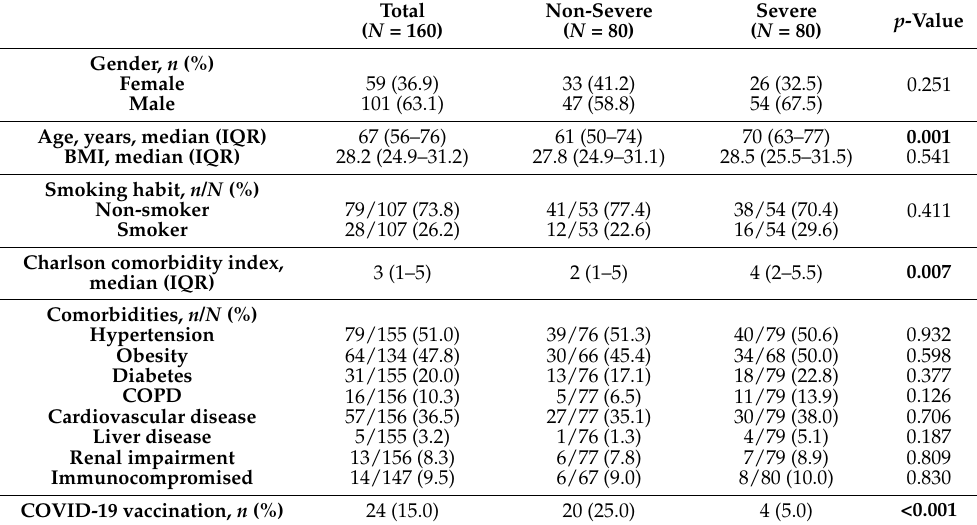
Table 1. Summary of baseline characteristics of enrolled patients. Baseline demographic, clinical features (comorbidities), and vaccination status of the enrolled patients ( n = 160). Patients were stratified according to the severity of the disease into a “non-severe” group and a “severe” one. Data are presented as either percentage or median and interquartile range (IQR). Results of the comparison between “non-severe” vs. “severe” patients are shown in the right column ( p -value). Significant results are shown in